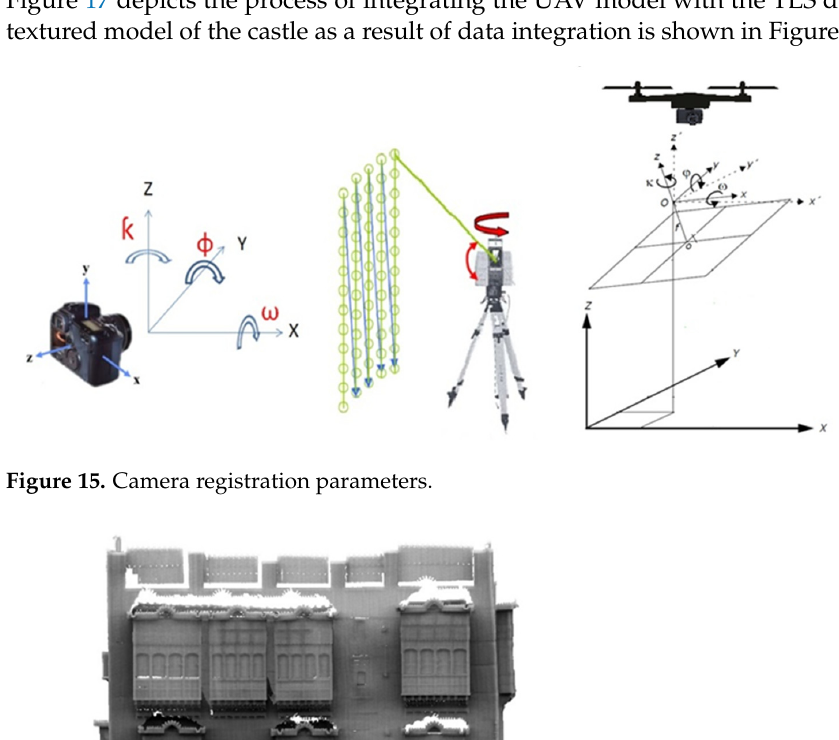
( c ) Figure 14. ( a ) Point cloud generation from UAV images. ( b ) UAV–SfM digital surface model. ( c ) UAV 3D model. 5. TLS and UAV Data Fusion The most challenging aspect of multi-sensor data fusion is aligning and converting all point cloud data to the same coordinate system, i.e., the two datasets should be associ- ated with the same spatial location. Besl and McKay [57] developed the Iterative Closest Point (ICP) algorithm, which is now a widely used method of dataset registration. The basic principle of ICP is to consider the nearest point to be a correlated point in the other cloud. It is carried out by iteratively converting and rotating a free dataset to a fixed one